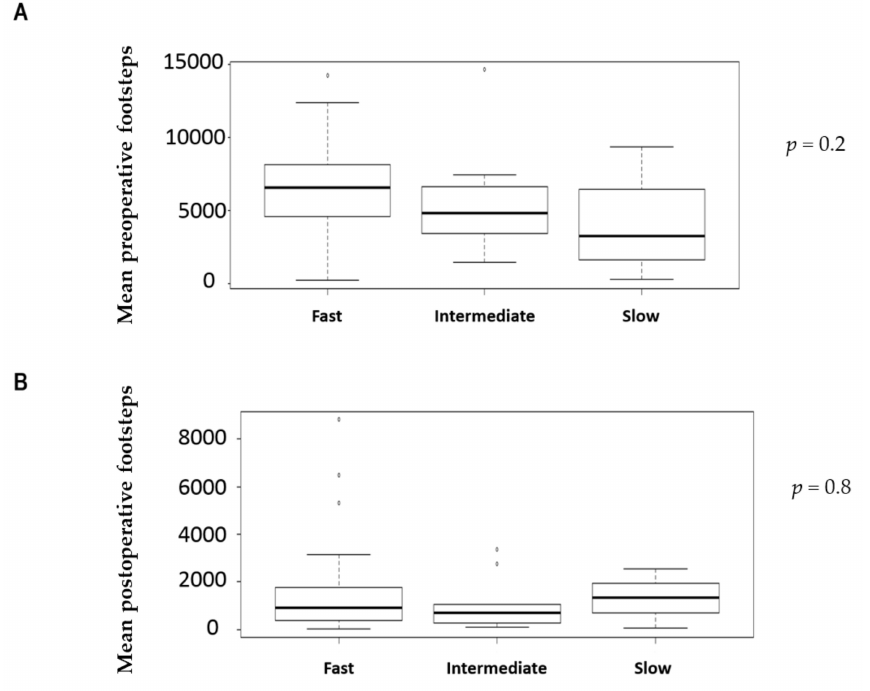
Figure 2. Comparison between Timed Up-and-Go Test (TUGT), preoperative, and postoperative footsteps: ( A ) Comparison between mean preoperative footsteps and TUGT classification (slow, intermediate, and fast groups) ( B ): Comparison between mean postoperative footsteps and TUGT classification (slow, intermediate, and fast groups)